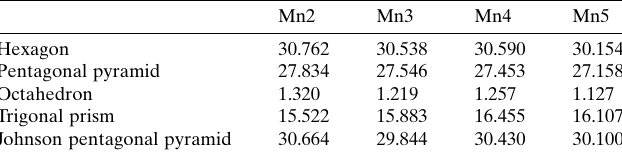
Table 7 Continuous shape measurement (CShM) values ( SHAPE 2.1 ) for the six- coordinate manganese ions of 2 .